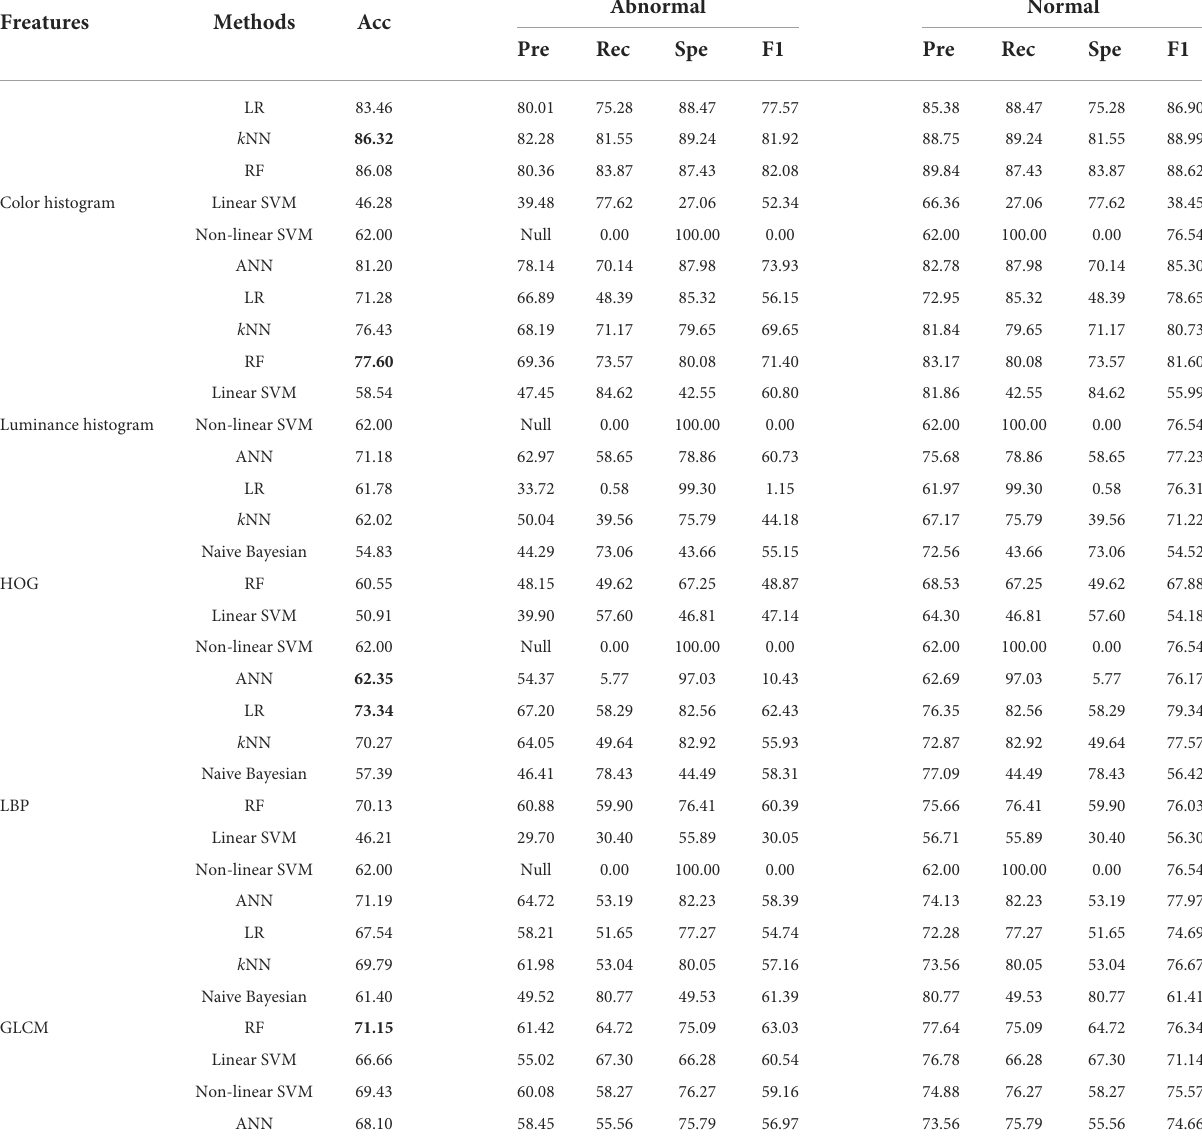
TABLE 4 Classification results of five image features using different classifiers in the 120 × 120 pixels sub-database of GasHisSDB [In (%)]. Freatures